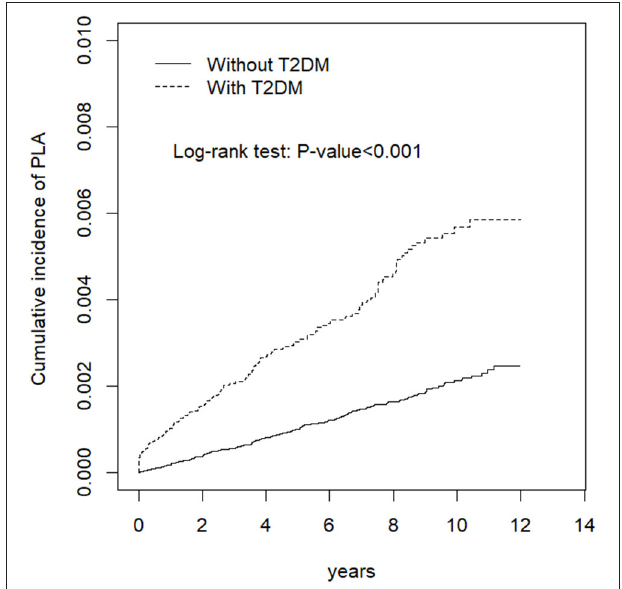
FIGURE 2 | Cumulative incidence of PLA in the T2DM and comparison cohort.